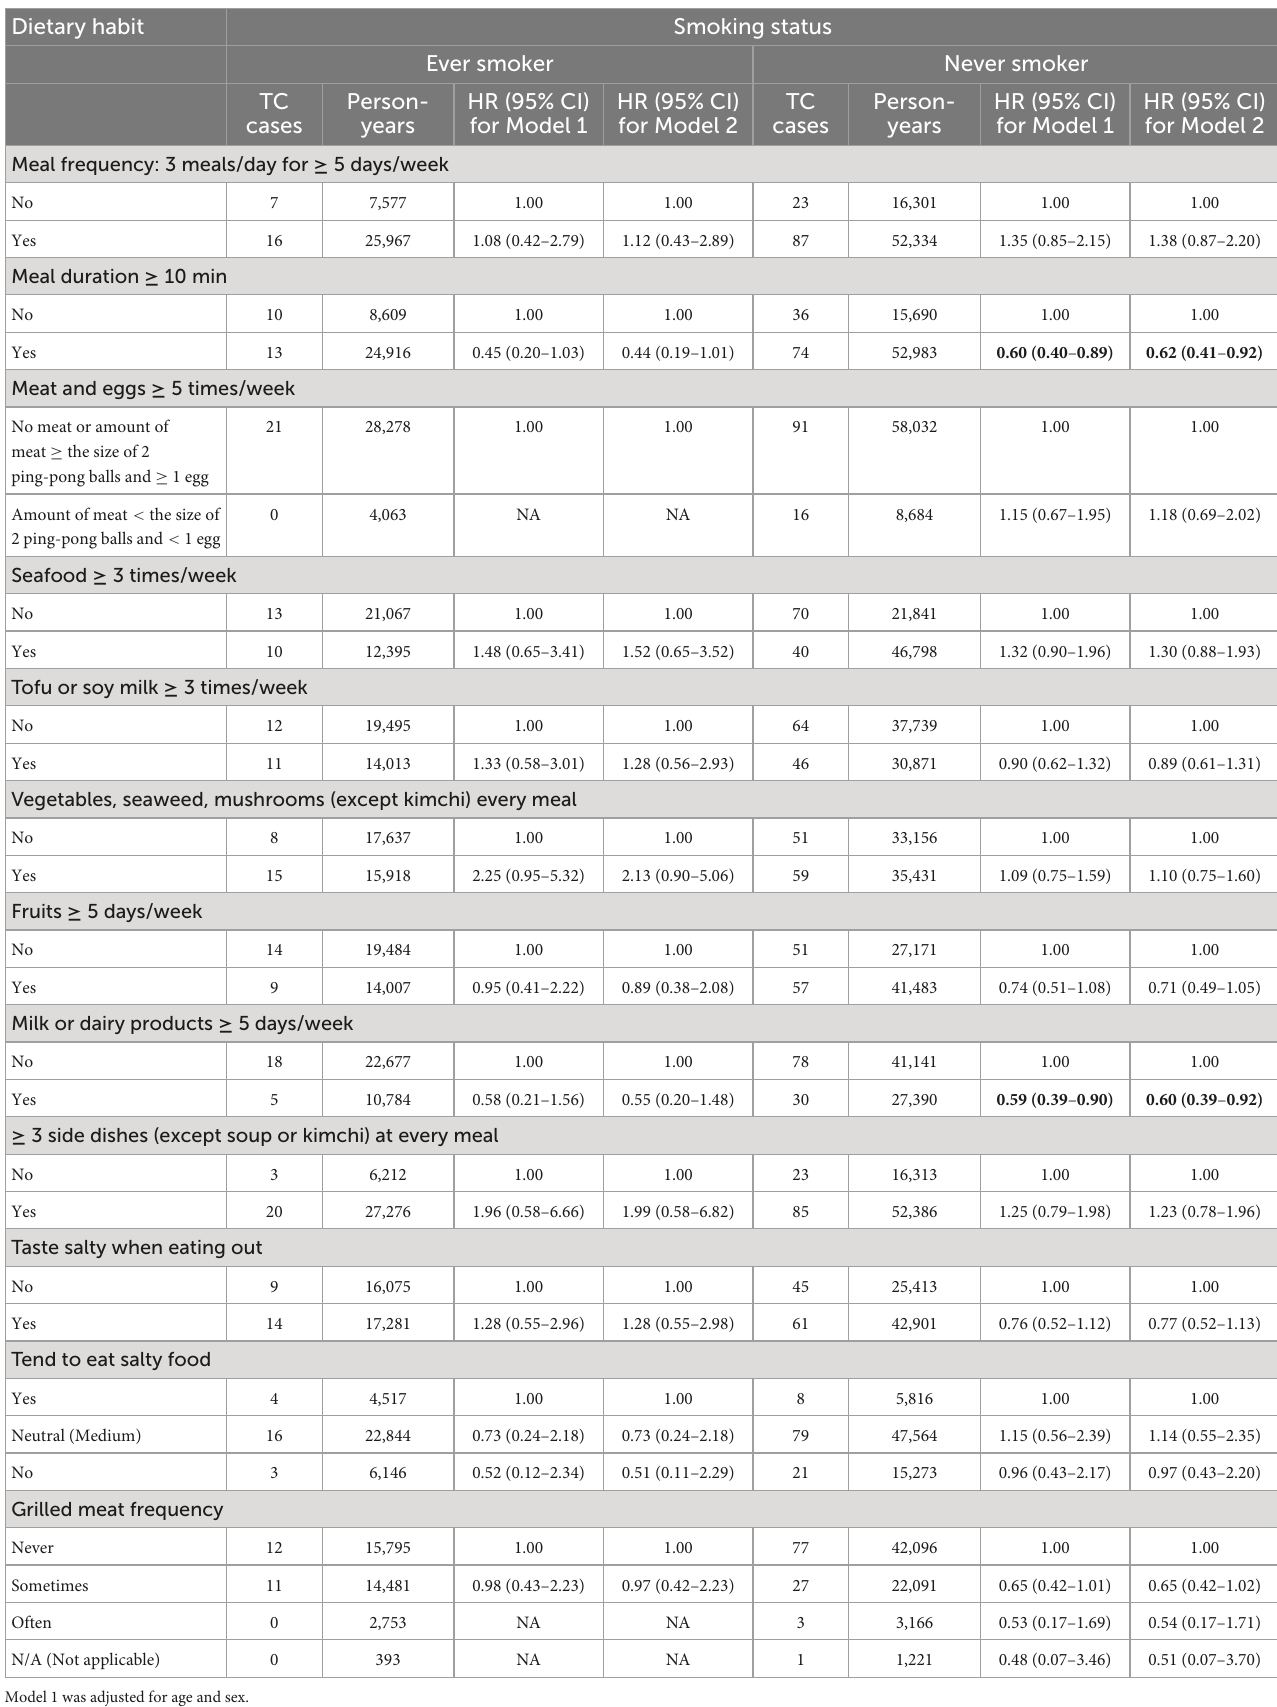
TABLE 5 Hazard ratios (HRs) and 95% confidence intervals (CIs) of incident thyroid cancer (TC) related to dietary habits by stratification of smoking status. Dietary